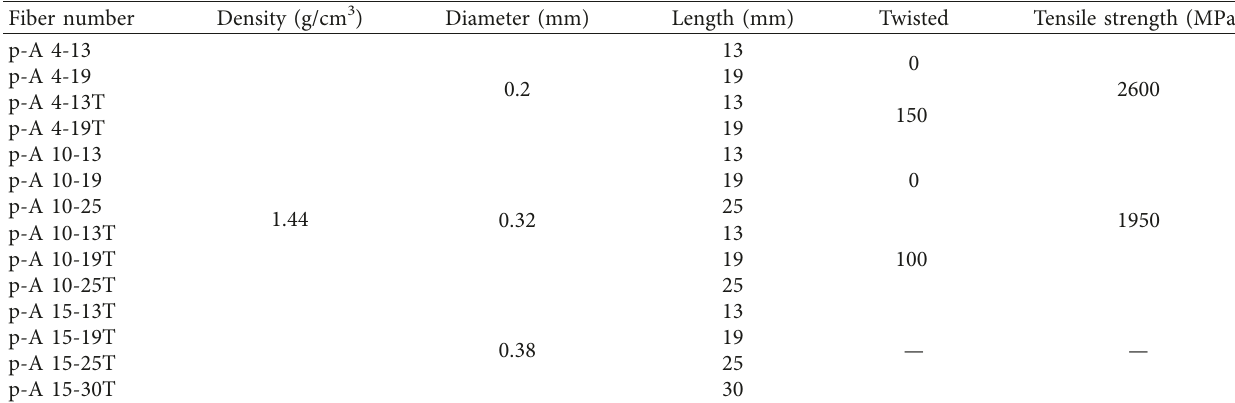
Table 9: Physical properties of p-A